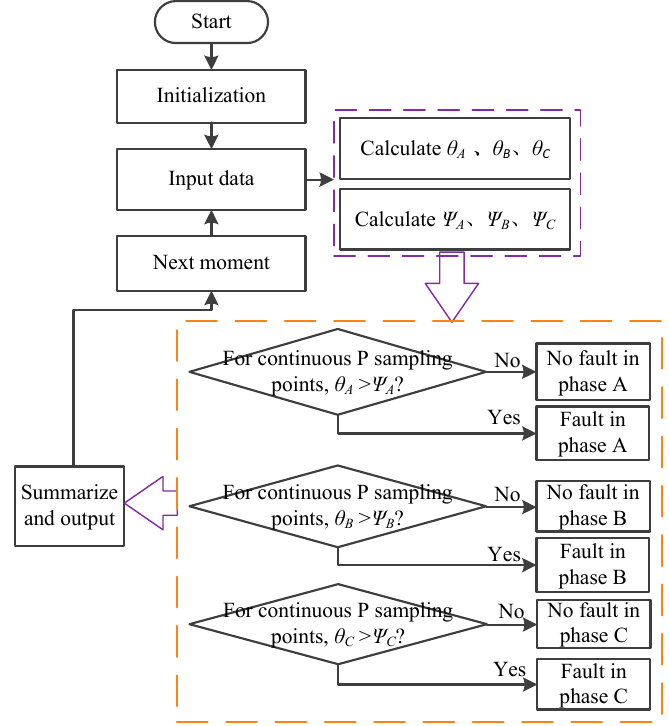
Figure 5. Flow chart of fault detection.